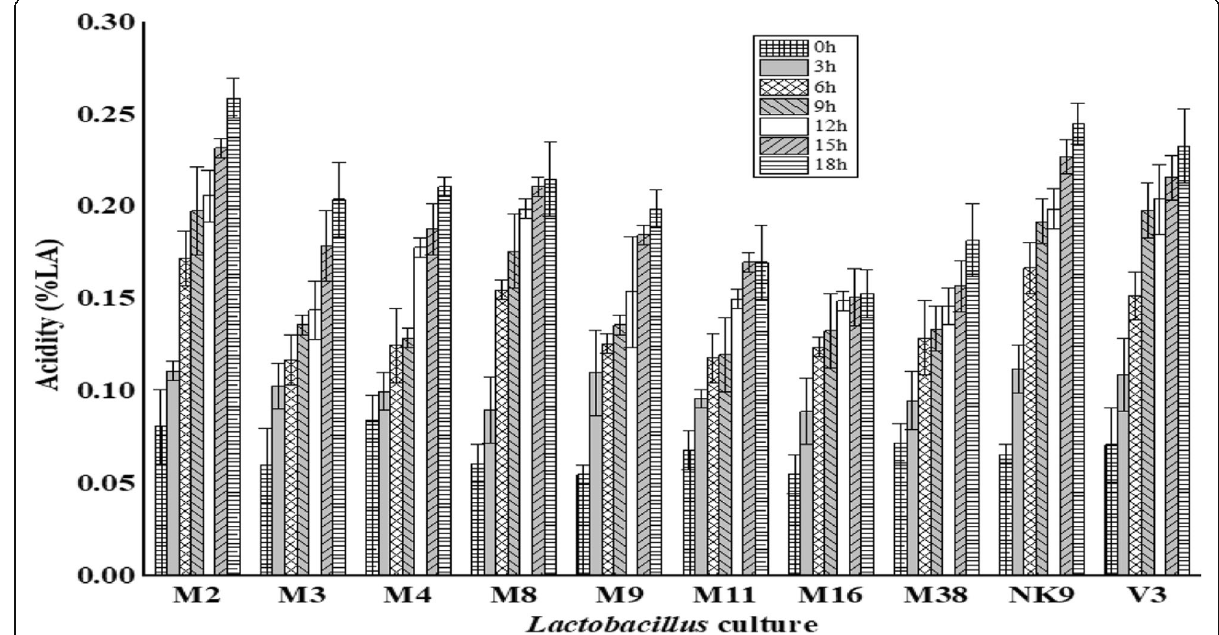
Fig. 2 Change in acidity (%LA) produced by Lactobacillus cultures incubated for different hours at 37 °C in soy milk